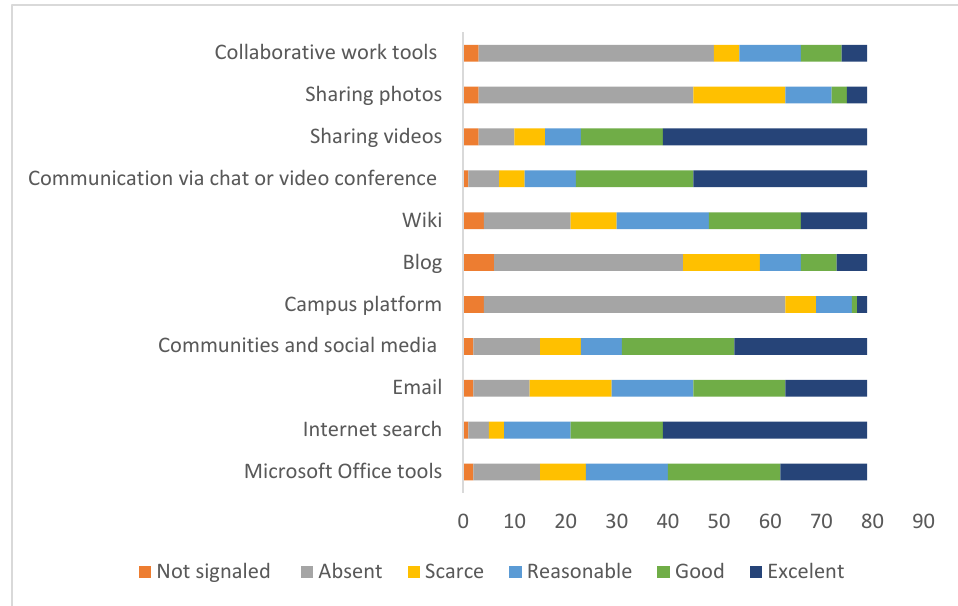
Figure 4. 5th grade s tudent’s level of knowledge about web applications or services. When asked about activities performed on devices connected to the Internet, students prefer watching videos, listening to music and using instant messaging applications.